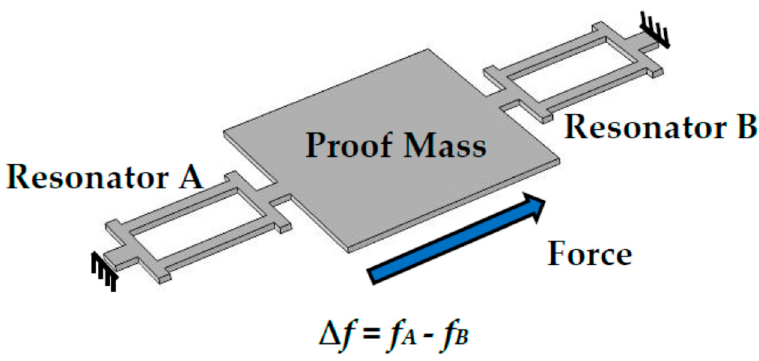
Figure 1. The structure of the resonant micro-electro-mechanical systems (MEMS) accelerometer.